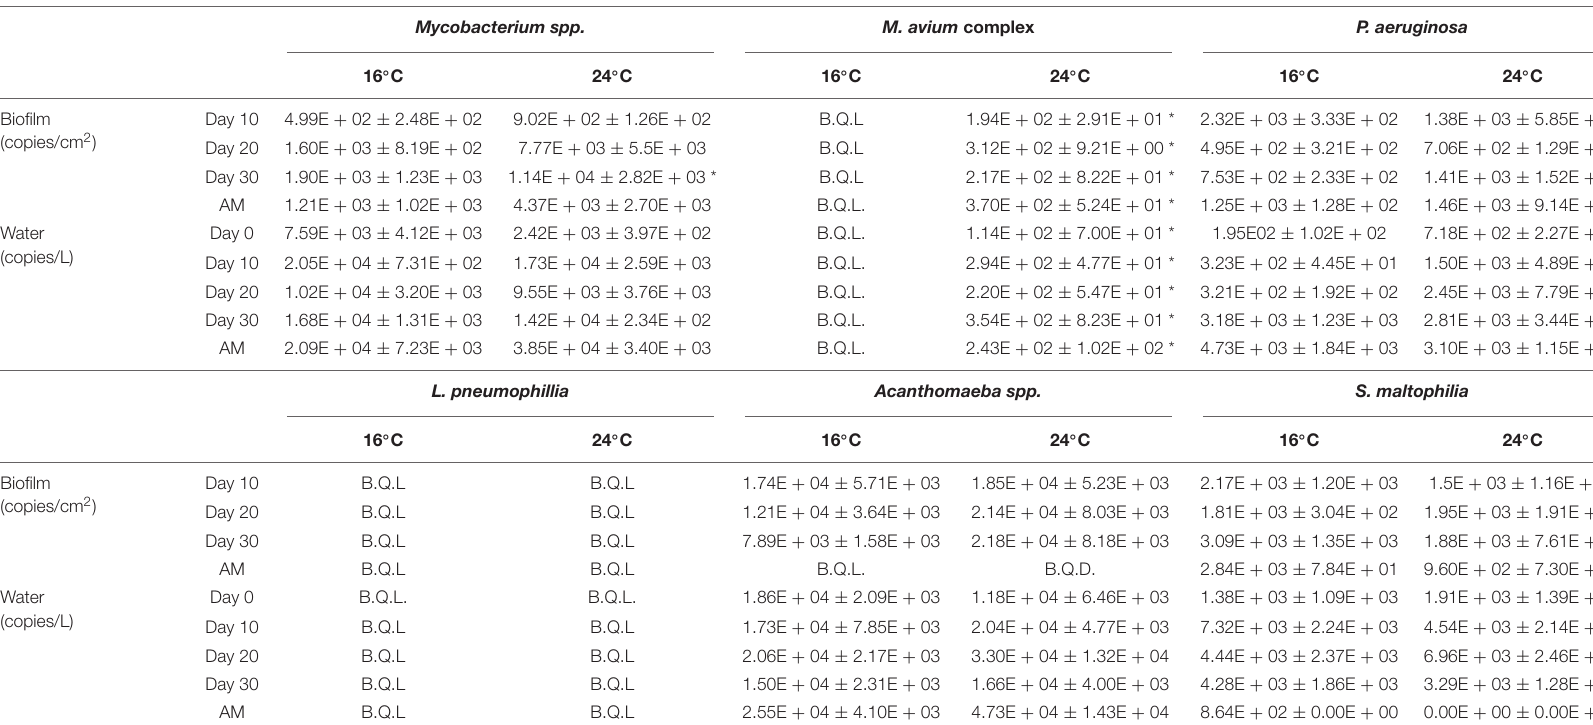
All values represent an average of three replicates ± standard deviation. “B.Q.L” correspond to number of genes below quantification limit. *p-value ≤ 0.05 from Mann–Whitney U